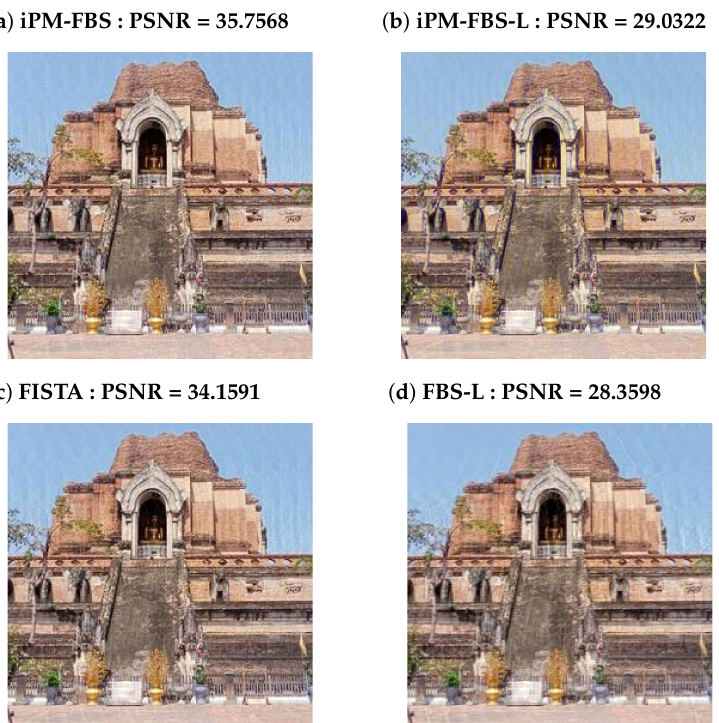
Figure 4. The images recovered in scenario II in case of τ = 10 − 8 . ( a – d ) Images recovered using iPM-FBS, iPM-FBS-L, FISTA, and FBS-L,